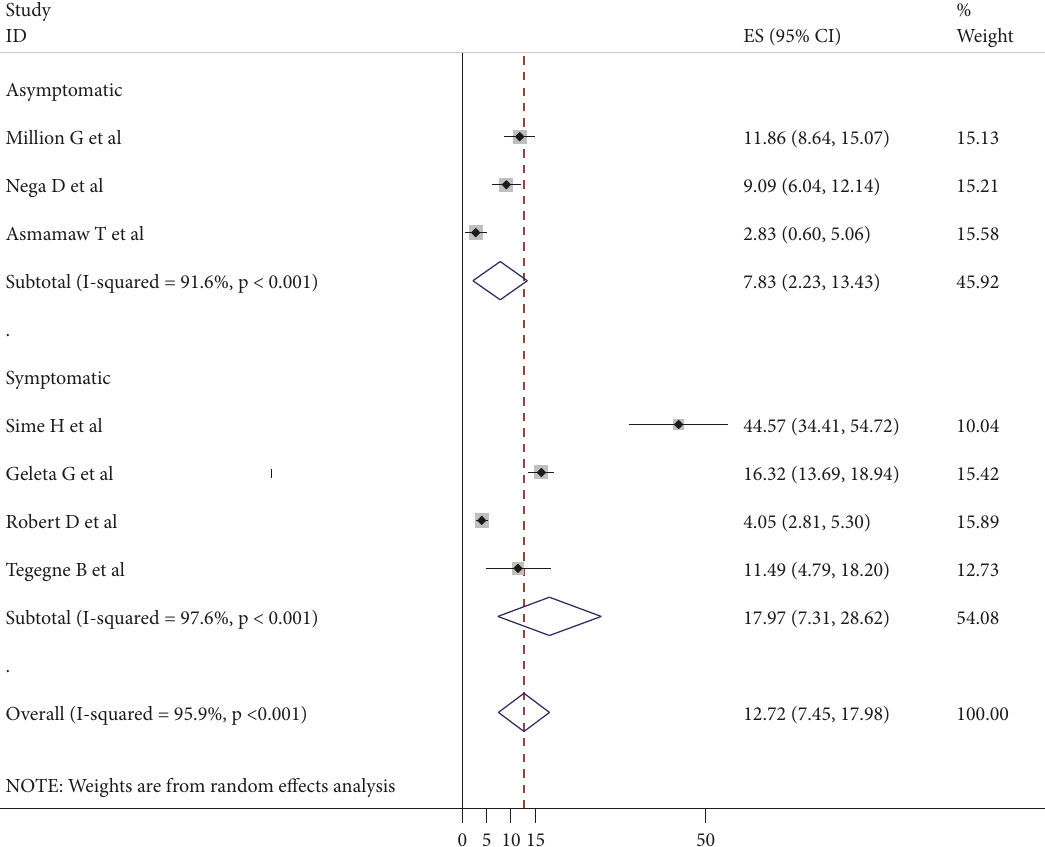
Figure 2:Thepooled estimatesof theprevalenceof malaria among pregnantwomen fromrandom effectmodelbytype ofcases. Themidpoint andthe lengthof eachsegmentindicatedprevalenceand a95% CI, whereasthe diamond shapeshowed thecombined prevalenceof all